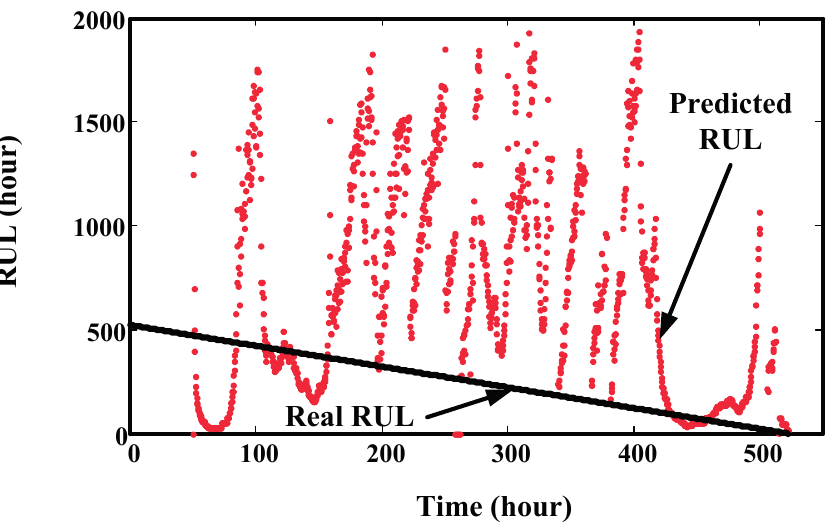
Figure 18. Comparison of real RUL and predicted RUL of the gearbox degradation data.